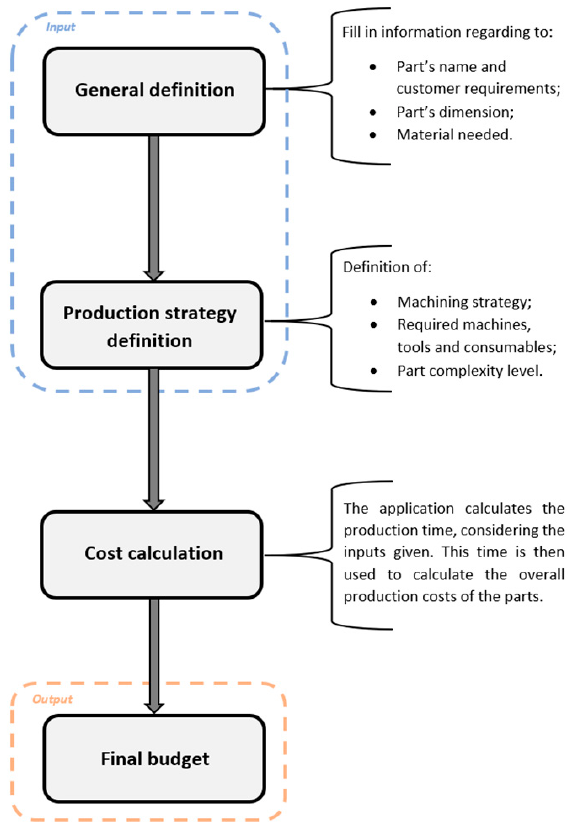
Figure 3. Schematic representation of the working principle of the developed tool, for the cost estimation of machined